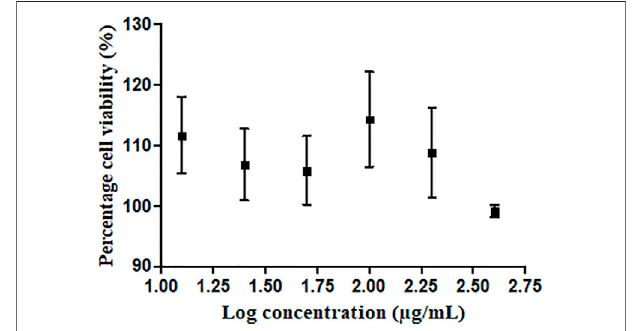
FIGURE 3 | Dose-response curve depicting HaCat cells treated with G. radlkoferi EtOH leaf extract.